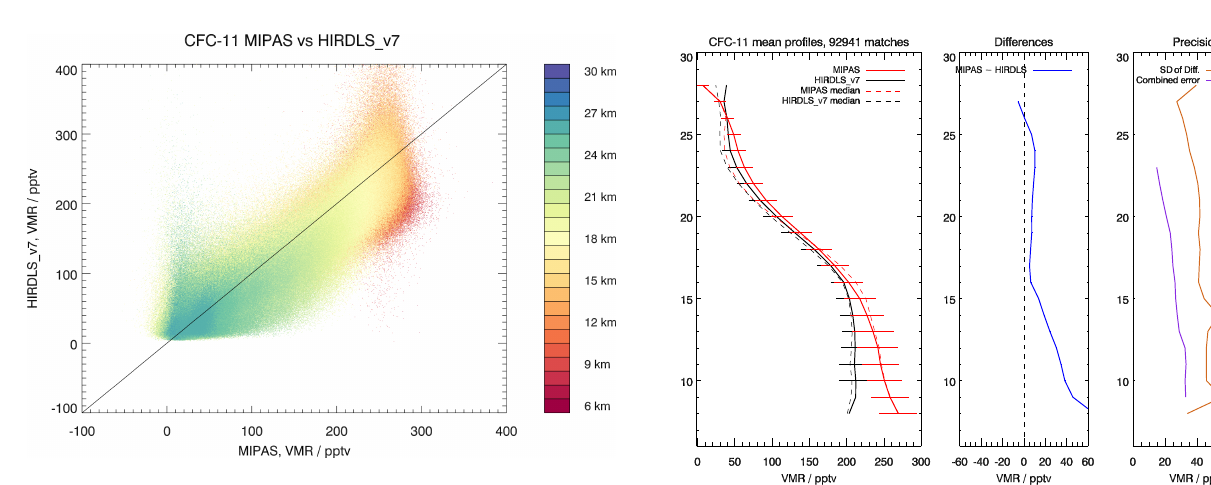
Figure 8. Comparison of mean profiles of MIPAS CFC-11 (left panel, continuous red line) and HIRDLS (left panel, continuous black line) for the years of 2005–2008. The error bars include the total error in the case of MIPAS and the estimated error – which is derived from the average of 10 sets of 12 consecutive profiles of regions with little variability (Gille et al., 2014) – in the case of HIRDLS. The dashed lines show the median of each data set. The middle panel shows the mean difference (blue) of these profiles and the standard error of the mean. The right panel shows the combined error (purple) of the instruments and the standard deviation of the differences